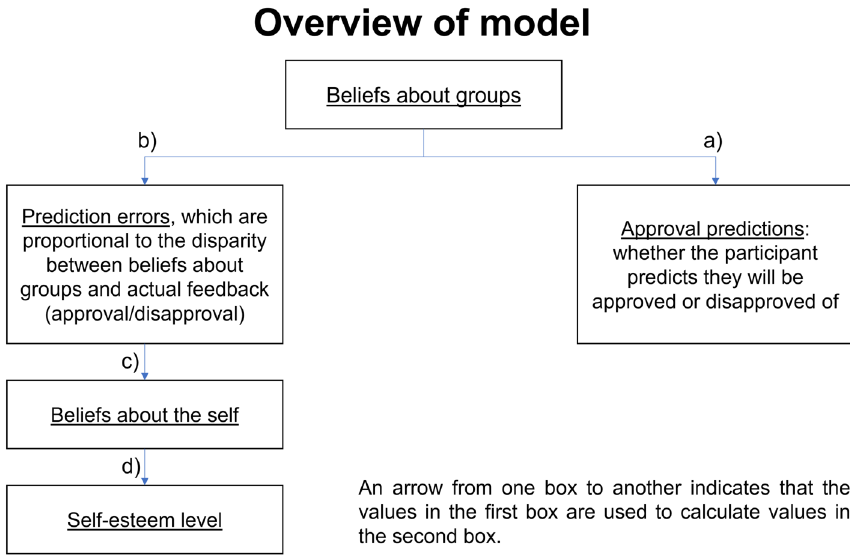
Figure 5. Overview of the belief-based hub-and-spokes model (see also Fig.